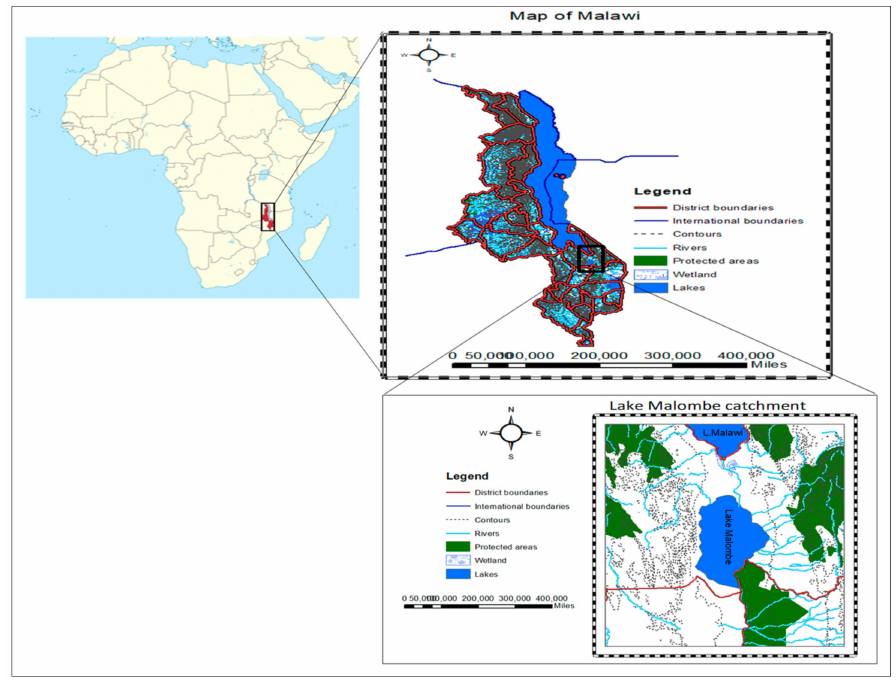
Figure 1. Map of Lake